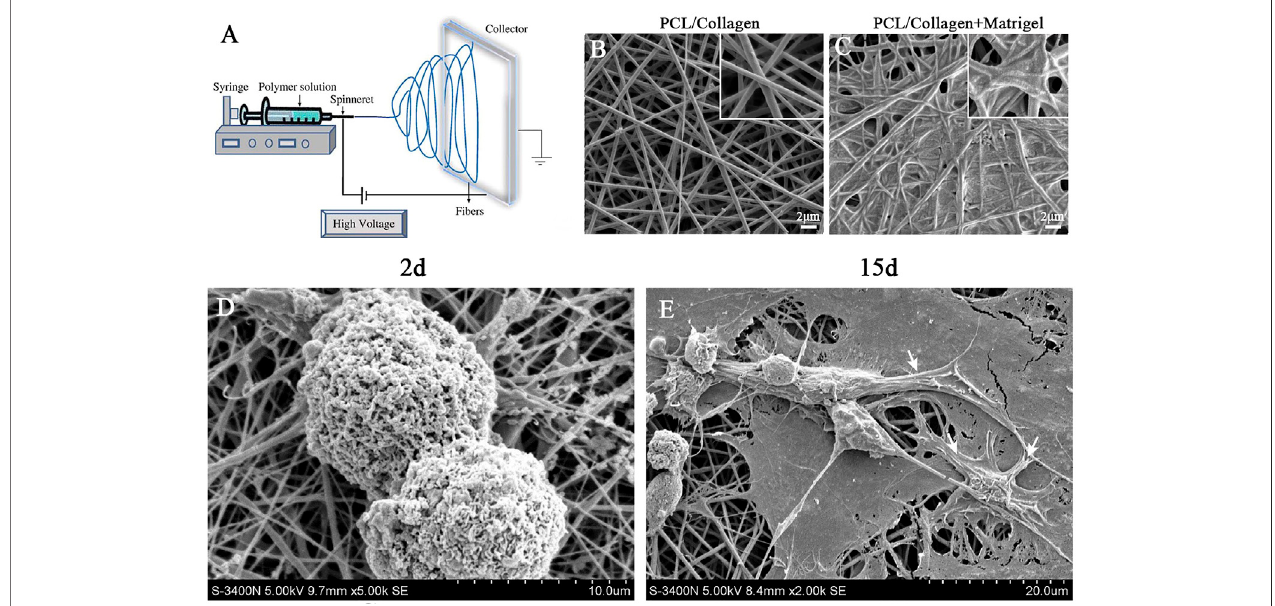
FIGURE 1 | Electrospinning was used to prepare and characterize nano fi brous scaffold. (A) Schematic diagram of electrospinning technology. (B) SEM micrographs of PCL/collagen nano-scaffold without matrigel coating. (C) SEM micrographs of PCL/collagen nano-scaffold with matrigel coating. (D) SEM micrographs of iPSCs colonies cultured on nano-scaffold at day 2. (E) SEM micrographs of iPSC-CMs colonies cultured on nano-scaffold at day 15. White arrows indicate CM-like morphology. Scale bar in (B – C) : 2 μ m.